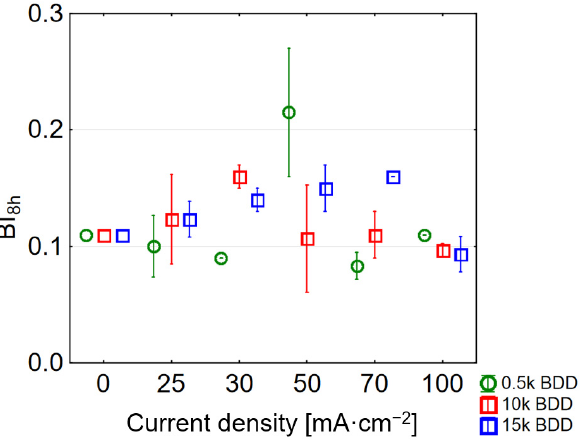
Figure 6. Influence of various current densities and electrodes used on BI (BI values after 8 h of LL treatment for different current densities applied).